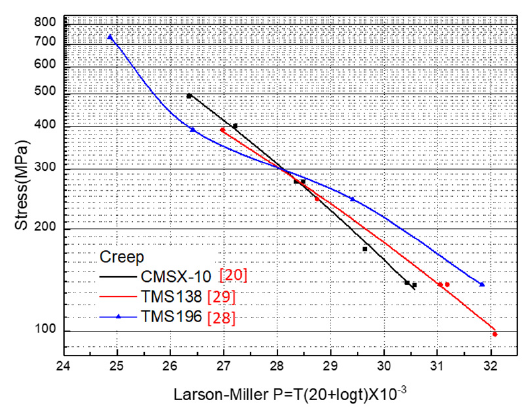
Figure 5. Larson-Miller plot of three different generations of single crystal superalloys [20,28,29].